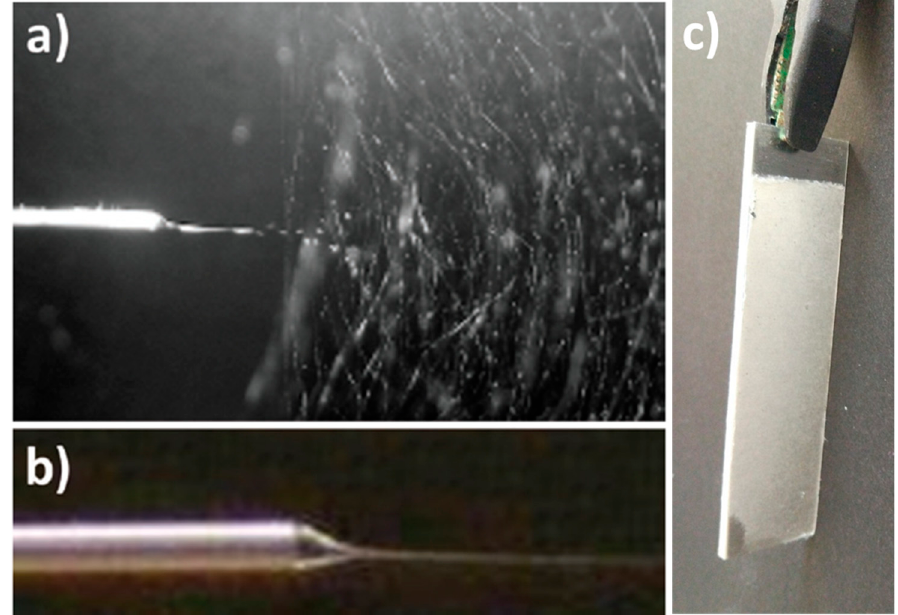
Figure 3. ( a,b ) The aspect of the fibres being electrospun towards the cathode from the needle which contains the polymeric solution and a detail of the Taylor cone formed at the tip of the needle; ( c ) The aspect of the final coating based on the electrospun fibres onto the reference metallic substrate (6061-T6). Reprinted with permission of [22].